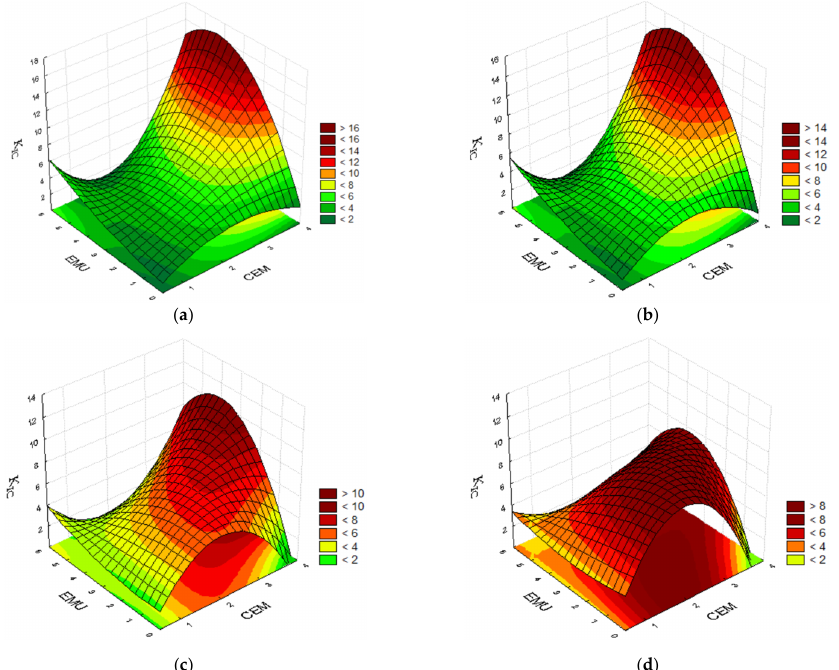
Figure 9. Plots for fracture toughness K IC at the temp. of 20 °C, taking into consideration the cement and bitumen emulsion contents and the polymer emulsion content of ( a ) 0.0%; ( b ) 0.5%; ( c ) 2.0%; and ( d ) 3.5%. The mixture’s fracture toughness test conducted at 20 °C confirmed the high cement content’s contribution to obtaining the best results with no or minimum polymer content. The addition of 2.0% polymer modifier minimally lowers the obtained results of fracture toughness K IC , but makes it possible to reduce the cement and bitumen emulsion contents in the mixture. An increase in the polymer modifier content to 3.5% allows for an even greater reduction in the content of other binders in the mixture. Near maximum fracture toughness results are already obtained at 1.0% of cement content and 1.0% of bitumen emulsion content. It is worth noting that the maximum values of the aforementioned parameter are lower than for the subbase containing 0.5% of polymer, however they are more uniform for a broader range of component contents. Figure 10 below presents the plot for analysing the recycled mixtures’ fracture toughness K IC and the variation in the parameter along with an increase in temperature.